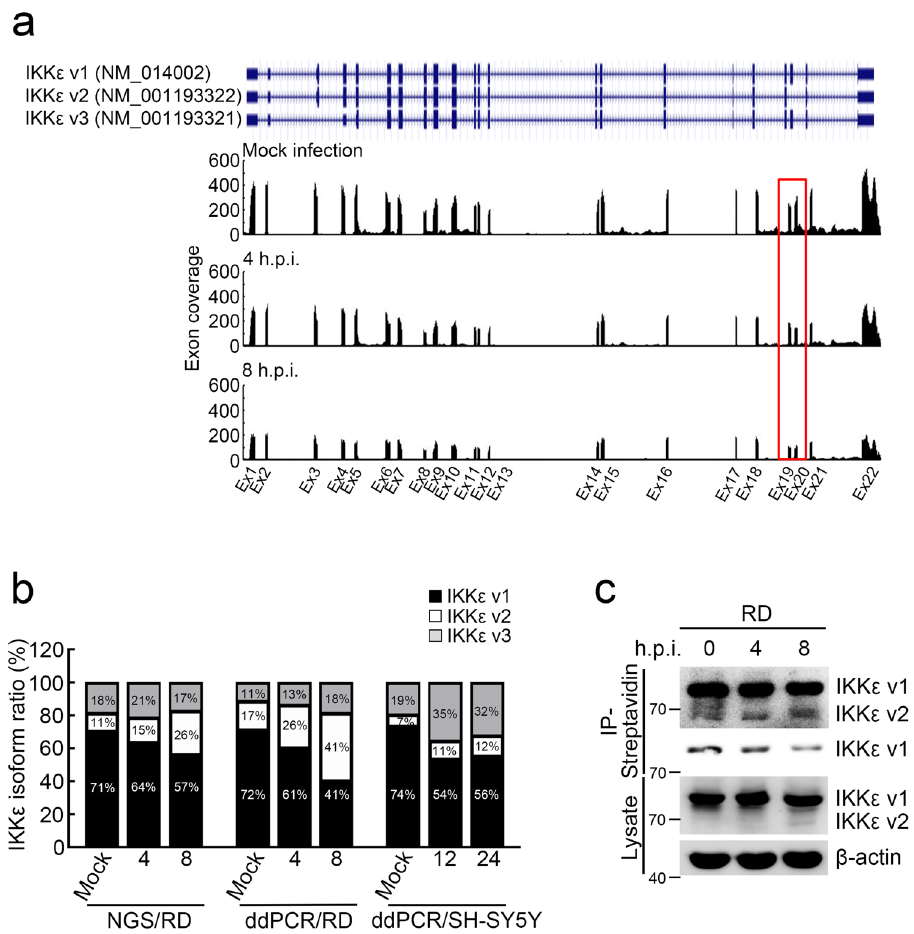
Fig. 1 EV71 infection triggers IKK ε isoform switching. a IKK ε is located at NC_000001.11 (206470243..206496890) of chromosome 1 in GRCh38. Each exon coverage of IKK ε is illustrated and the isoform switching occurs in exon 20 at 4 and 8 h.p.i. compared with mock infection group. b IKK ε isoform switching is validated by droplet digital PCR (ddPCR). IKK ε v2 was upregulated while IKK ε v1 was downregulated in response to EV71 infection determined by NGS (left panel for RD cells) and ddPCR (middle panel for RD cells and right panel for SH-SY5Y cells). The proportion of each IKK ε isoform was indicated. c IKK ε isoform switching is con fi rmed by western blotting. The Click-iT AHA assay was performed to measure newly synthesized IKK ε v1 and v2. The synthesis of IKK ε v2 was increased while IKK ε v1 was decreased in EV71 infection. The upper panel of IP-Streptavidin is a long exposure while the lower panel is a short